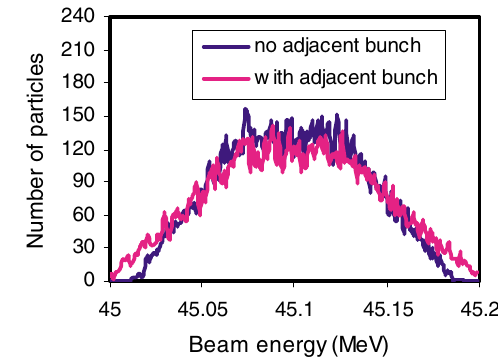
FIG. 3. (Color) Energy spread comparison with and without adjacent microbunches in the